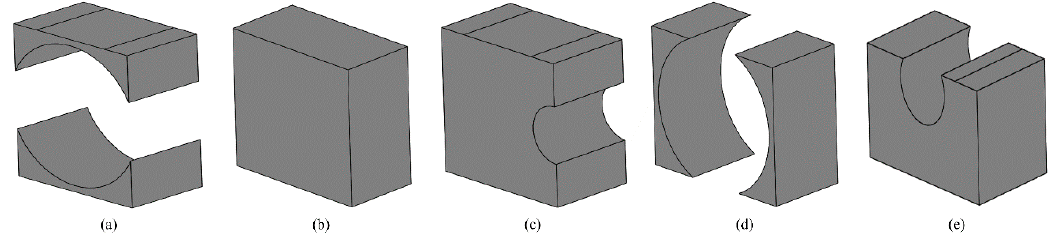
Figure 10. Unfeasible design solutions: ( a ) L ≤ 2 × r, ( b ) L ≤ FA, ( c ) r ≥ l1 ≥ L − r, ( d ) H ≤ 2 × r, and ( e ) r ≥ h1 ≥ H − r.